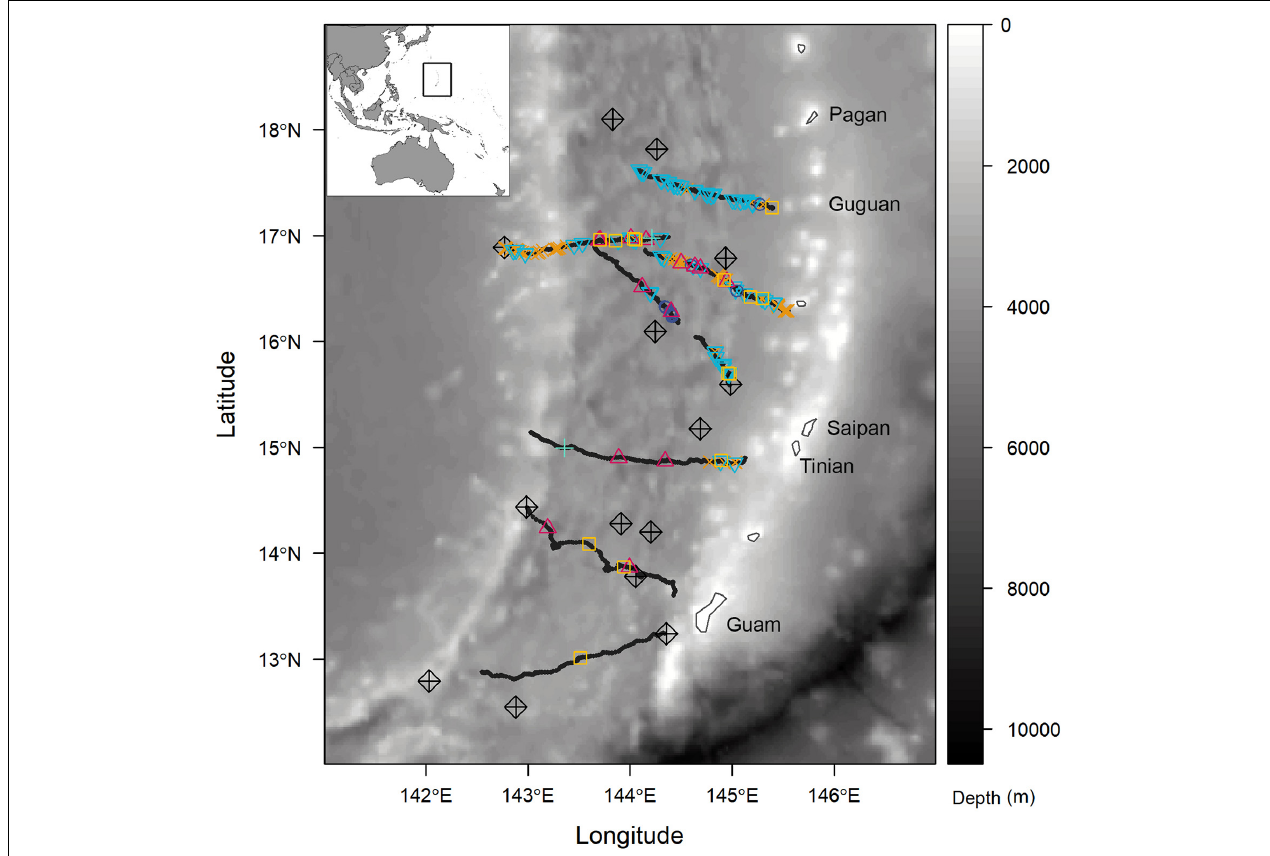
FIGURE 1 | Bathymetric map of the Mariana Archipelago with DASBR tracks (bold black lines), acoustic detections (2-min files) of beaked whales and Kogia spp. (Blainville’s = blue downward triangle; Cuvier’s = orange “x”; Longman’s = purple circle; BWC = yellow square; Kogia spp. = pink upward triangle; unknown BW = teal cross), and locations of conductivity-temperature-depth (CTD) casts (black diamonds) overlaid. Bathymetry pulled from R-package “marmap” (Pante and Simon-Bouhet, 2013).